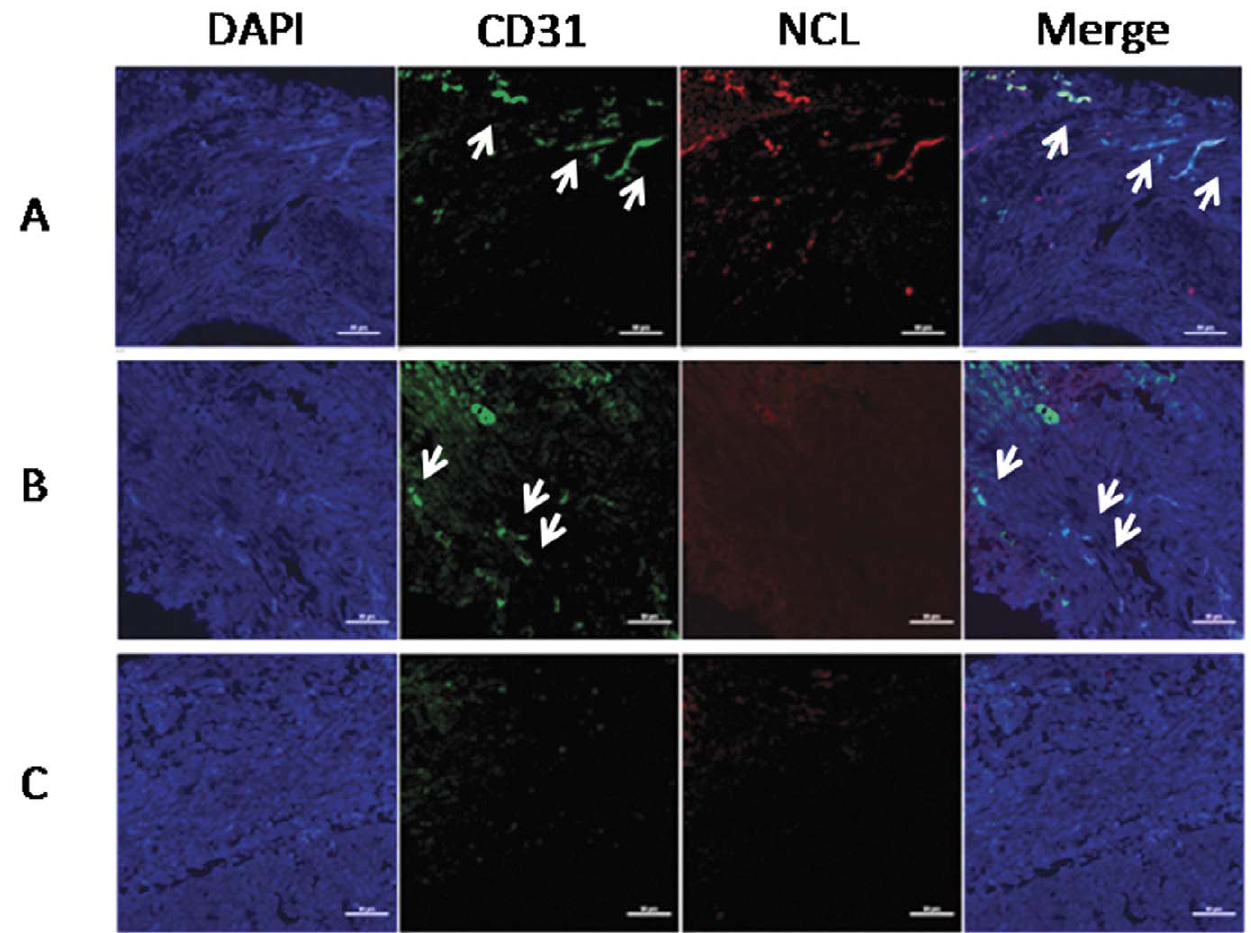
Figure 1. The NSCLC sections were divided into three groups based on the blood vessel density and nucleolin expression. The tumor blood vessels and nucleolin were stained with anti-CD31 (green) and anti-nucleolin (red), respectively. Nuclei were stained with DAPI (blue). Representative images from the three groups were shown here. (A) CD31 hi NCL hi , (B) CD31 hi NCL lo , (C) CD31 lo NCL lo . Scale bar, 50 m m.